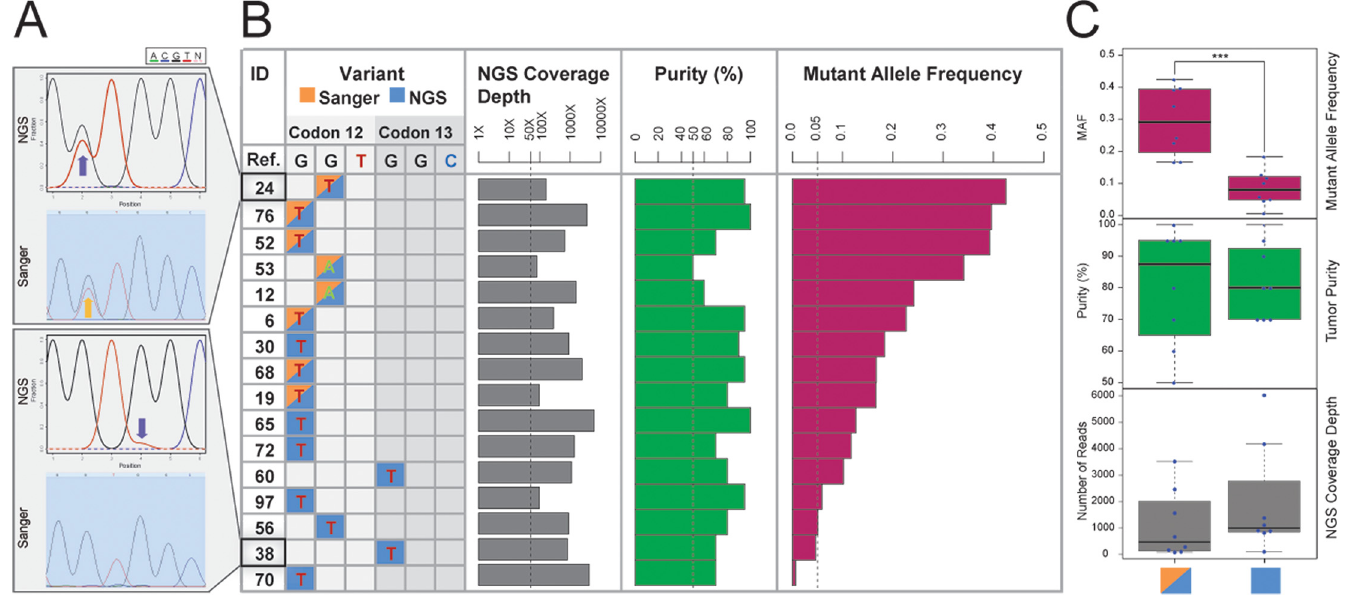
Fig 3. SNV Calling of KRAS Hotspots Using First- and Next-Generation Sequencing. (A) Sequencing chromatograms (Finch TV trace viewer v1.4.0) obtained from two tumor tissue examples showing concordance (sample 24) or discordance (sample 38) in KRAS SNV calling. (B) SNV calling at hot-spot loci in KRAS codon 12 and 13 for all 16 tumors using either of the two sequencing strategies. Calls by Sanger and NGS are colored in orange and blue, respectively. Calls by both platforms are colored in half orange and half blue. NGS coverage depth, purity, and MAF are also shown. (C) Boxplots of MAF, tumor purity, and coverage depth between discordant and concordant SNV calls are shown ( p -value = 0.0006, two-sided Wilcoxon test).